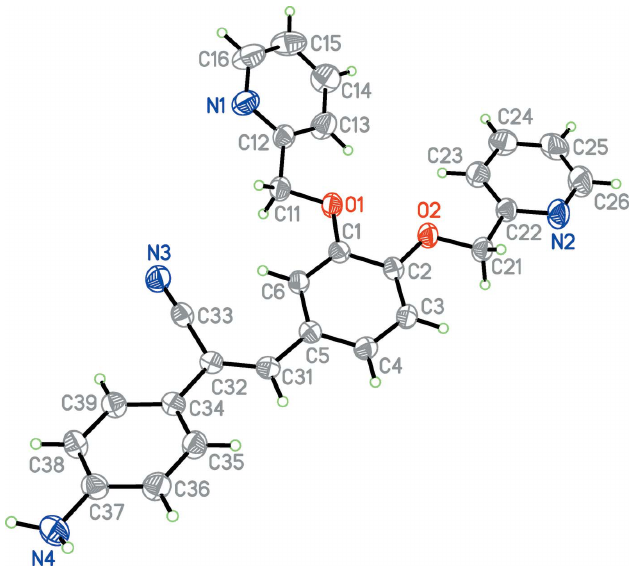
Figure 1 The structure of title molecule, showing the atom-numbering scheme. Displacement ellipsoids are drawn at the 30% probability level.